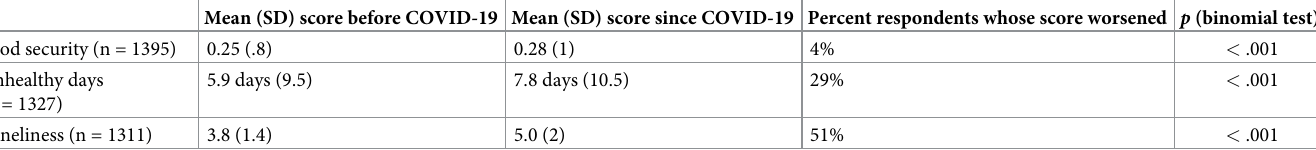
Scores for food security are assigned on a scale of 0–6: 0–1—High or marginal food security; 2–4—Low food security; 5–6—Very low food security. The score for unhealthy days is the number of unhealthy days in the last 30 days in terms of physical and/or mental health. The loneliness scale assigns scores on a scale of 3 (not lonely) to 9 (very lonely). The scores for unhealthy days and loneliness are not qualitatively interpreted any further (e.g., good or poor health). For all measures, both pre-pandemic and since the pandemic began, respondents exhibited the full range of